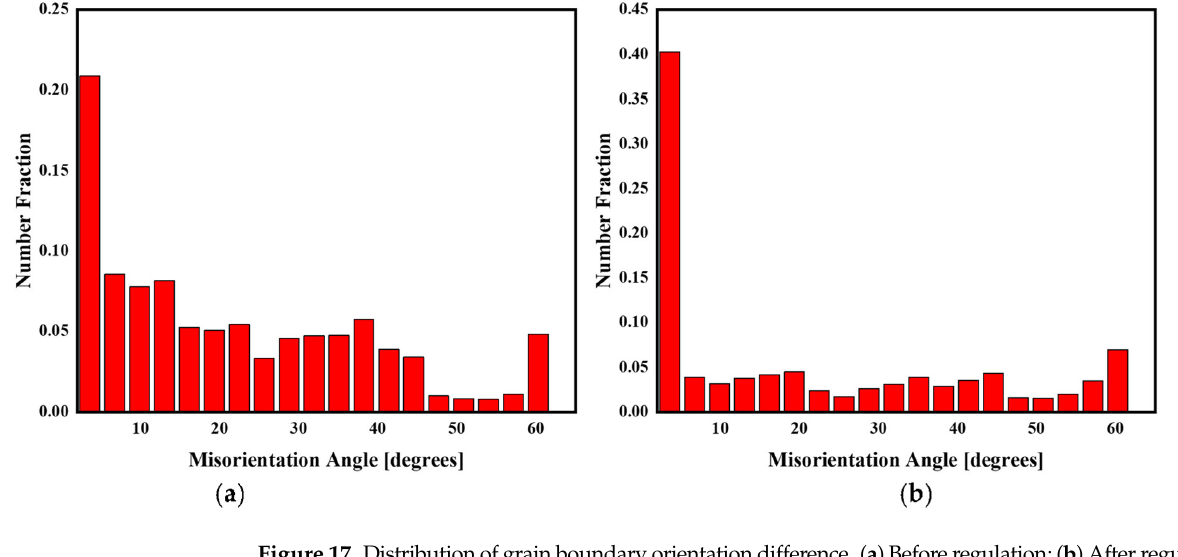
Figure 17. Distribution of grain boundary orientation difference. ( a ) Before regulation; ( b ) After